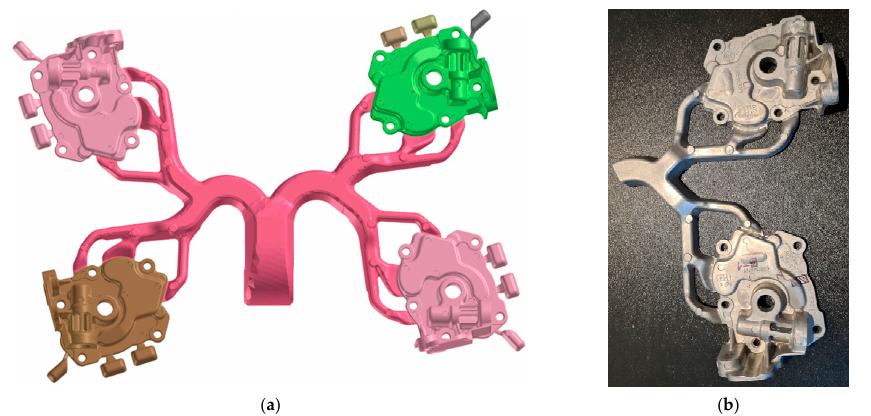
Figure 2. View of the bundle: geometric model (ProCAST) of the bundle made in a 4-cavity die used in the simulation ( a ) and an experimental part consisting of two test castings ( b ). A summary of the parameters of the high-pressure die casting process used in the tests is presented in Table 2. Table 2. Process parameters for obtaining selected test castings.